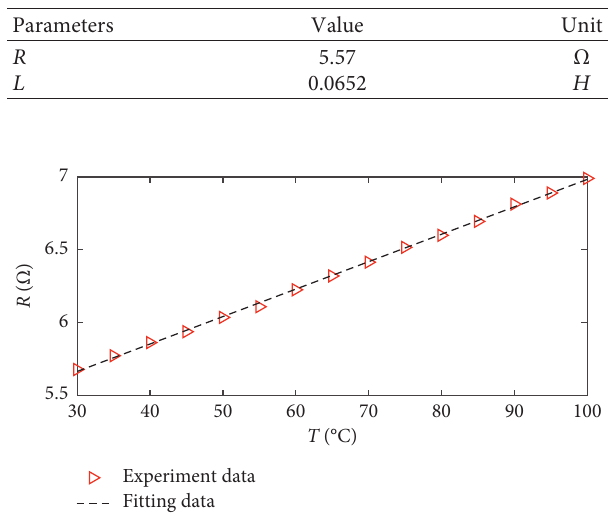
Figure 3: Coil resistance varies with temperature.